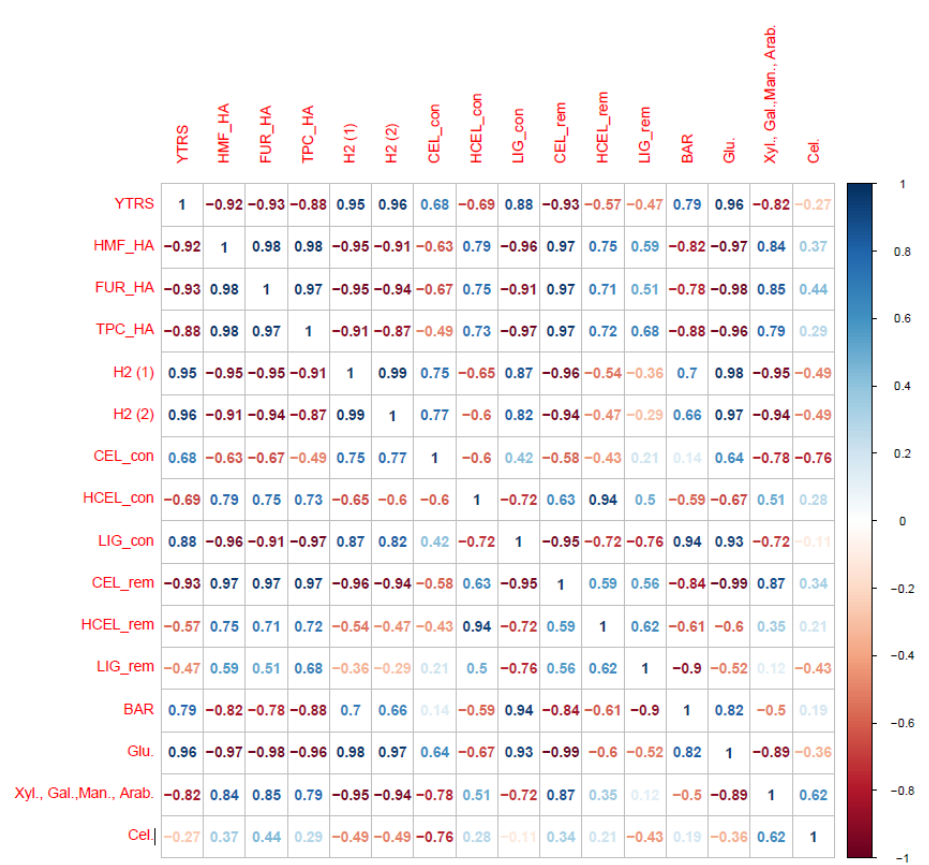
Figure 6. Correlation matrix for the compositions of biomass, enzymatic hydrolysates and hydrogen